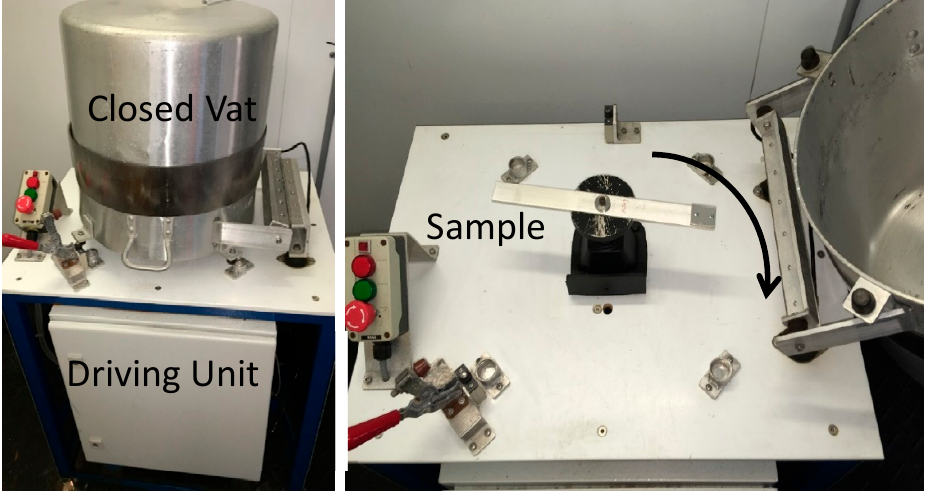
Figure 2. AMIL centrifuge adhesion test (CAT) apparatus.